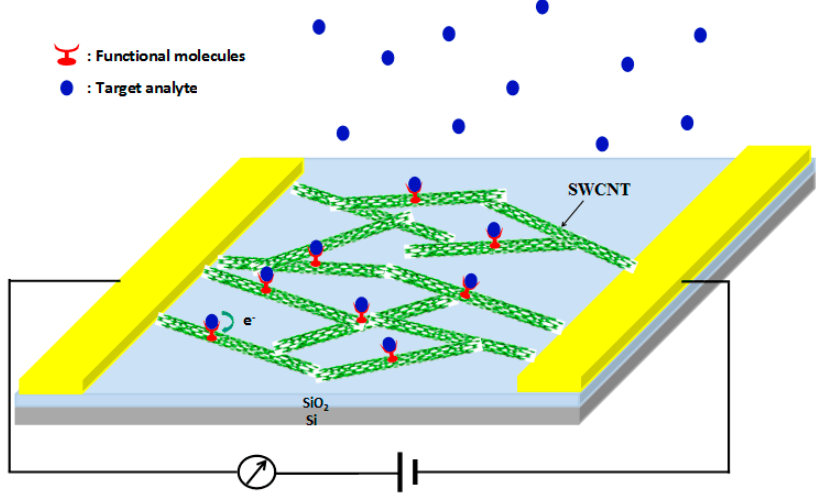
Figure 2. Schematic of configurations of CNT chemiresistive sensor.